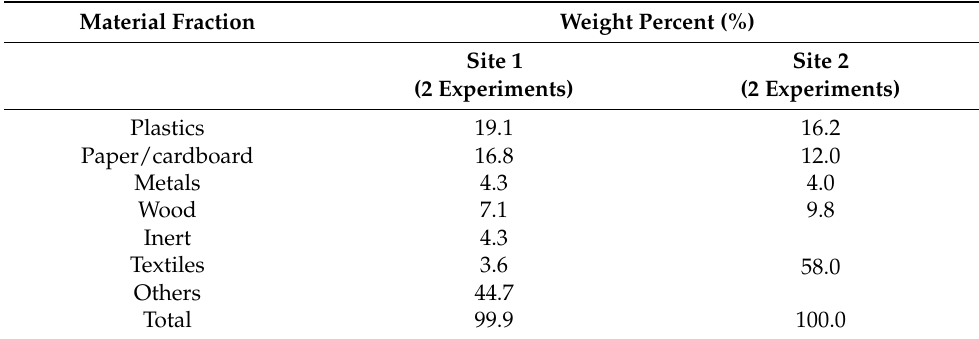
Table 1. Results on composition of mixed commercial waste from investigations made by Weißenbach [13] performed in 2018 and